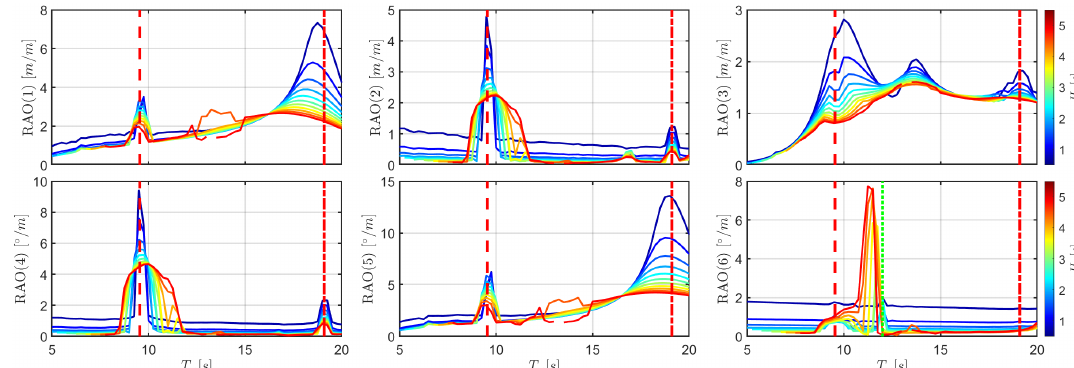
Figure 7. Response amplitude operator for configuration m 3 as a function of T w , for different H w , as shown in the color bar. The dashed and dash-dotted red lines correspond to T w = 1 T w = T n ,5 , respectively. The green dotted line refers to T w = 1